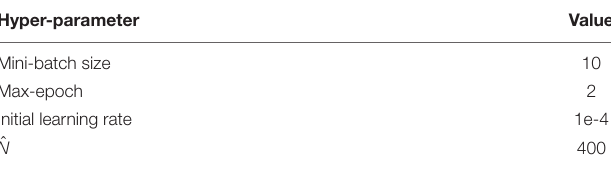
TABLE 2 | Hyper-parameter settings in the PBTNet.